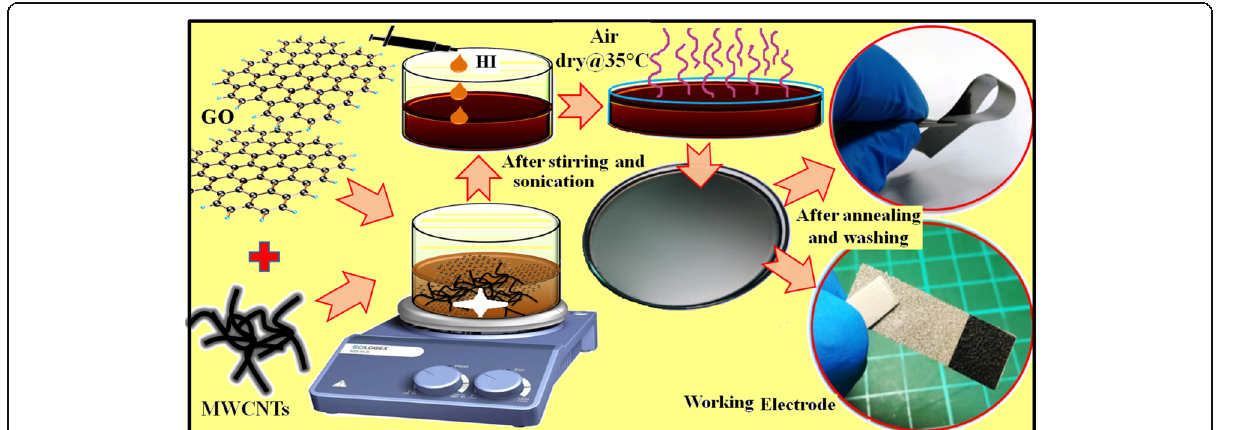
Fig. 1 Scheme of the synthesis of rGO, rGO/CNT papers, and electrode fabrication